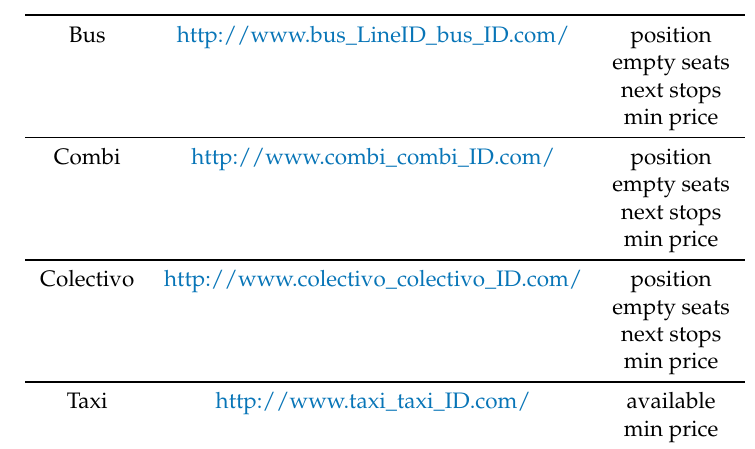
Table 3. URIs for the Public